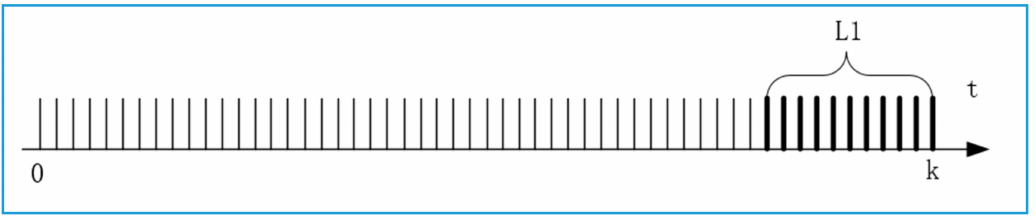
Figure 7. The schematic of SMP ( L 1 = N t h 1 ).